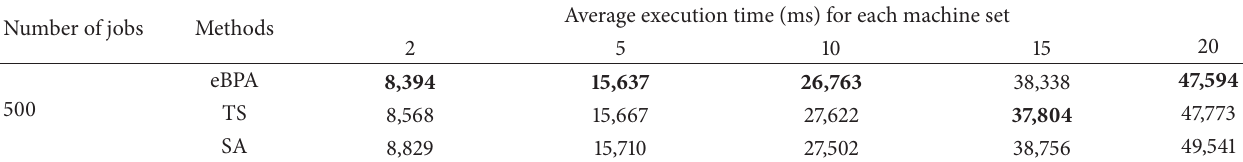
Table 2: The average execution times in milliseconds, per machine set, for the class of 500 jobs. Number of jobs Methods